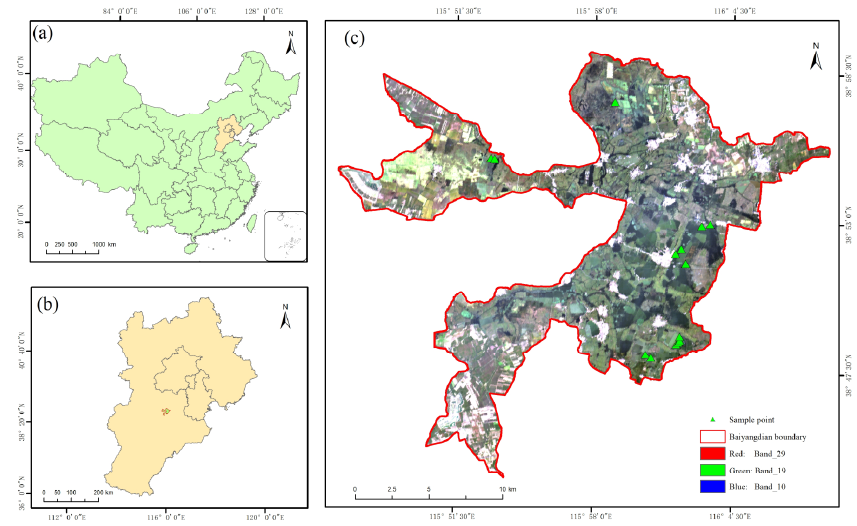
Figure 1. Maps of the study area ( a ) China, ( b ) Beijing-Tianjin-Hebei Province, ( c ) study sites at Baiyangdian